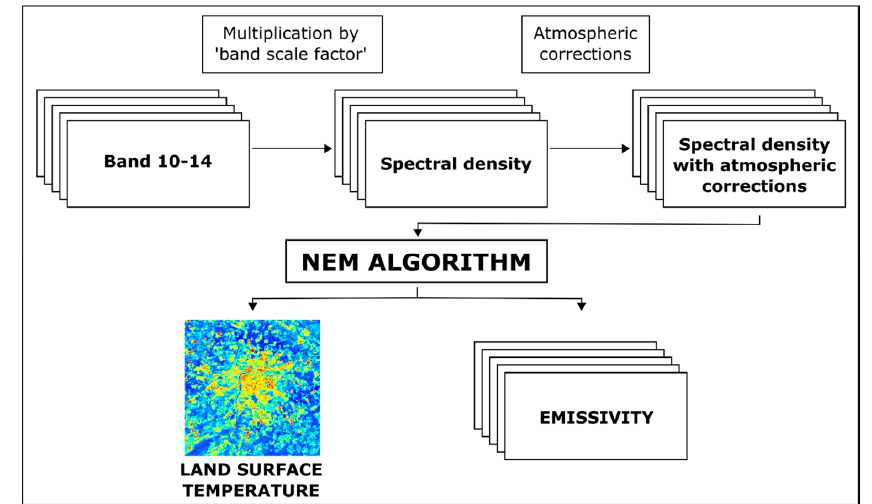
Figure 3. LST calculation from ASTER thermal images.